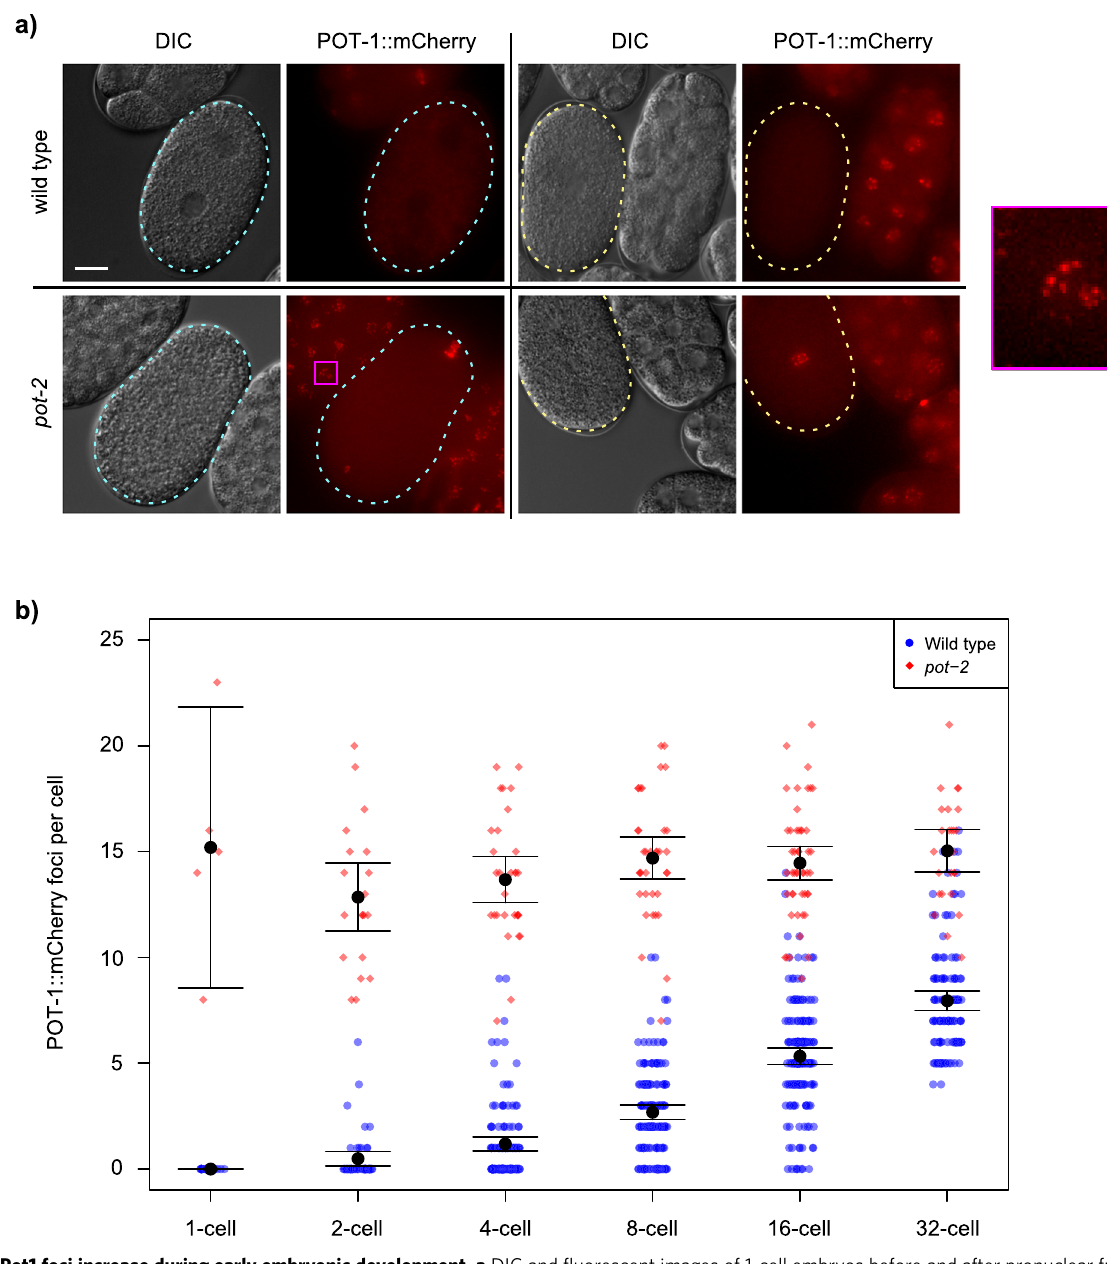
Fig. 1 Pot1 foci increase during early embryonic development. a DIC and fl uorescent images of 1-cell embryos before and after pronuclear fusion in either wild-type or pot-2 mutant strains. Cyan and yellow dashed lines indicate 1-cell embryos before and after pronuclear fusion, respectively. Scale bar is 10 µ m. The portion of the image indicated by the magenta square is shown at 10x higher detail to the right. b POT-1::mCherry foci per nucleus of individual cells of embryos from 1- to 32-cell stage in wild-type (blue circles) and pot-2 mutants (red diamonds). The difference between wild-type and pot-2 mutants is signi fi cant at every stage (Wilcox p < 10 − 5 ). Error bars are 95% con fi dence intervals. Central black dots are only modestly longer than those of wild-type (diagrammed in tag at the endogenous pot-2 locus using CRISPR/Cas9-mediated Supplementary Fig. 1e) 22 . Hermaphrodites from this outcrossed genome modi fi cation 32 . We con fi rmed that this version of POT-2 pot-2 mutant strain were crossed with males containing the pot- with an N-terminal epitope tag was functional by examining the 1::mCherry transgene, and freshly derived F3 pot-2 -/- mutant length of telomeric DNA of an mNeonGreen::pot-2 strain that had hermaphrodites were observed to possess high levels of POT-1:: been grown for at least 50 generations. Southern blotting revealed mCherry foci in all 1- and 2-cell F4 embryos (Supplementary telomeres of wild-type length, in contrast to the elongated Fig. 1f). Therefore, although telomeres of pot-2 mutant strains telomeres of pot-2 mutants (Supplementary Fig. 2a). Cytoplasmic gradually lengthen over many generations of growth, acute loss of mNeonGreen::POT-2 was observed at all embryonic stages and in POT-2 induces abundant POT-1::mCherry foci in the interphase all adult germ cells (Supplementary Fig. 2b). Like POT-1:: nuclei of early embryos. mCherry, mNeonGreen::POT-2 was strongly expressed in mature Given the strong effect of de fi ciency for pot-2 on early sperm, and embryonic mNeonGreen::POT-2 nuclear foci colo- embryonic POT-1::mCherry foci, we introduced an mNeonGreen calized perfectly with POT-1::mCherry foci (Supplementary